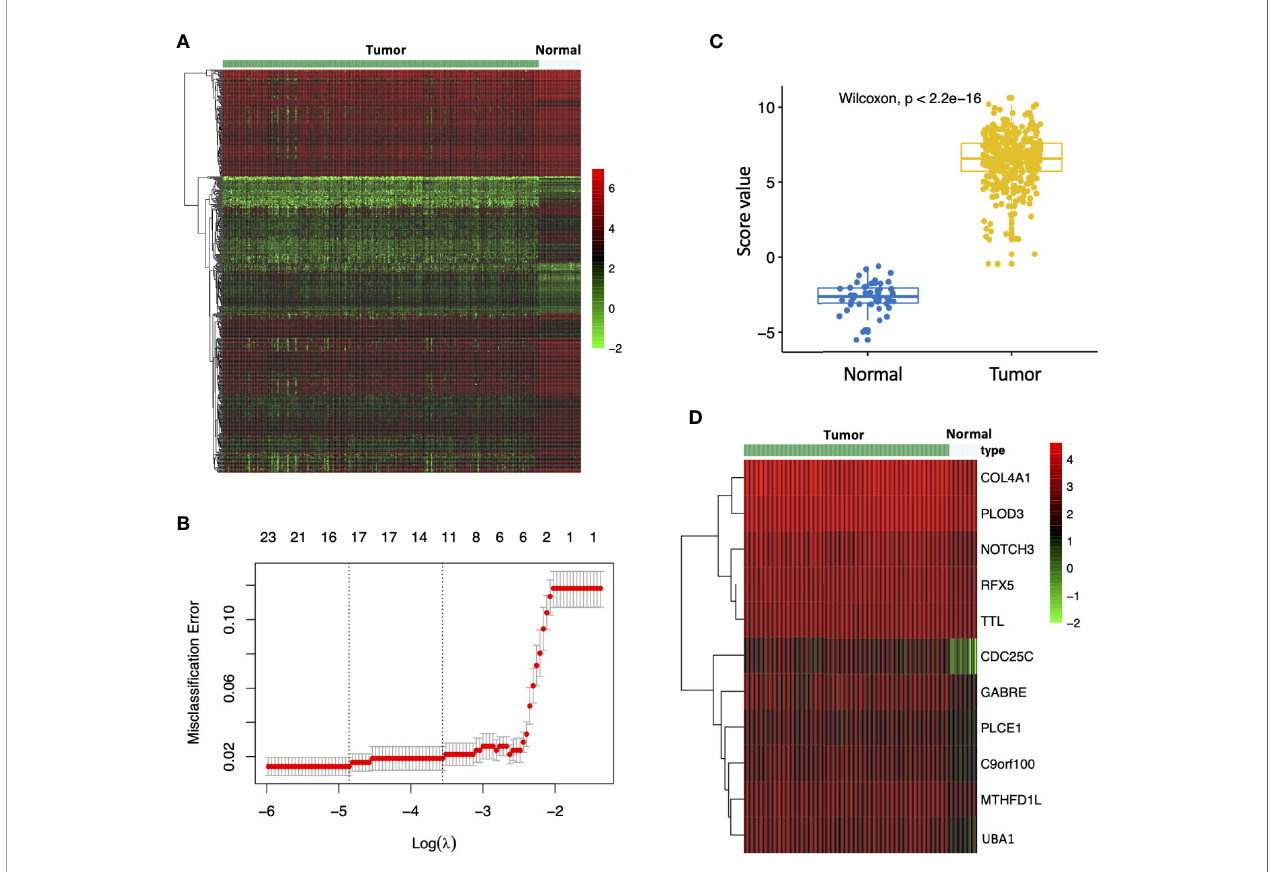
FIGURE 4 | Construction of the diagnostic model. (A) Expression pattern of MEturquoise module genes in TCGA HCC RNA-Seq samples (n=423). (B) Misclassi fi cation error for different numbers of variables revealed by the LASSO regression model. The red dots represent the value of the misclassi fi cation error for different numbers of variables in the LASSO regression model, and the gray lines represent the standard error (SE). The vertical dotted lines represent optimal values, indicating the number of the most important genes. (C) Distribution of diagnostic score values in different groups. The box plots indicate the median value and interquartile range of diagnostic score values. (D) Expression pattern of signature genes identi fi ed by the LASSO regression model in TCGA HCC RNA-Seq